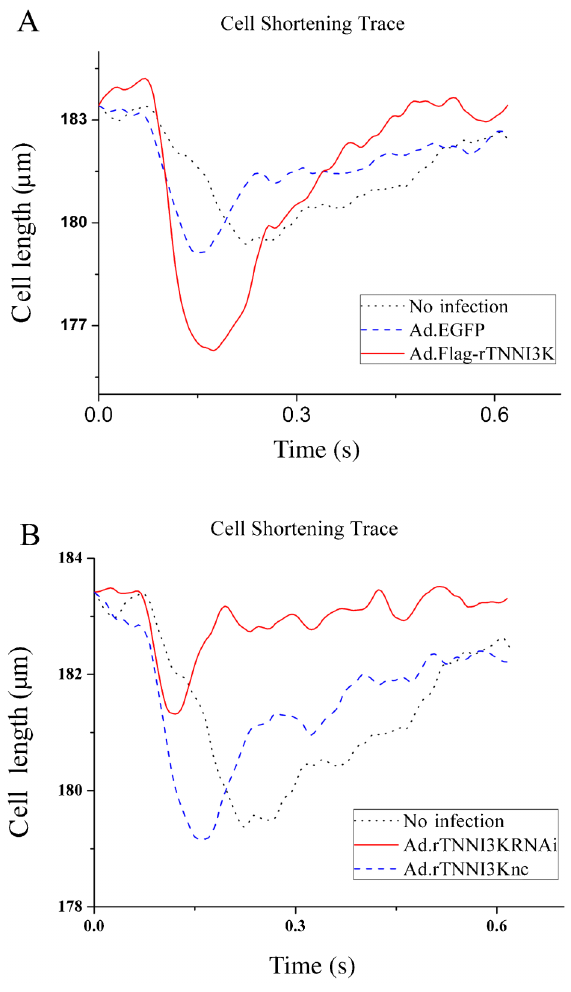
Figure 5. Effects of human cardiac troponin I-interacting kinase (TNNI3K) on cardiomyocyte contraction. A , Representative traces of cell shortening from non-infected cardiomyocytes or cardiomyocytes infected with Ad.GFP or Ad.rTNNI3K. B , Representative traces of cell shortening from non-infected cardiomyocytes or cardiomyocytes infected with Ad.TNNI3Knc or